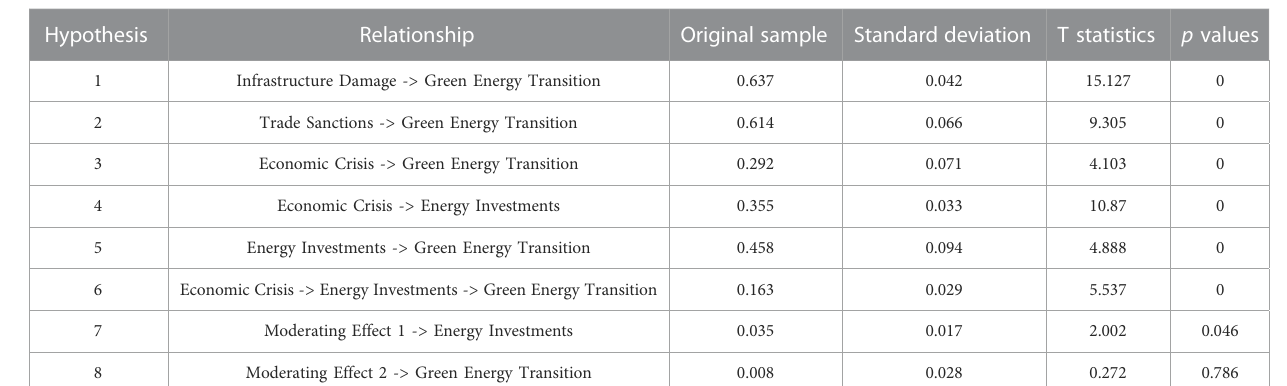
TABLE 6 Path coef fi